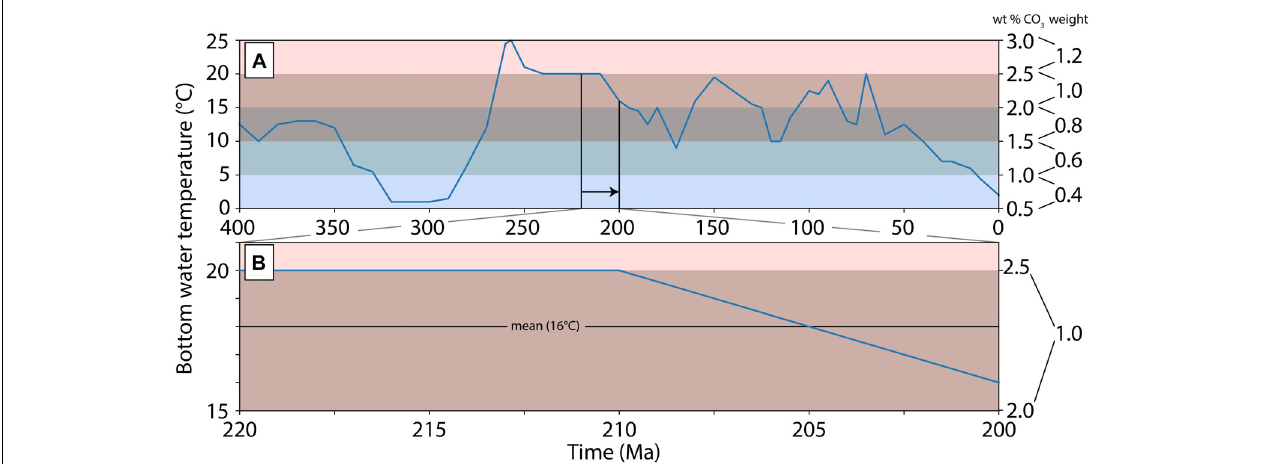
FIGURE 3 | (A) Bottom water temperature curve from 400 to 0 Ma with a resolution of 10 Ma after Müller and Dutkiewicz (2018). Wt% carbonate and the applied weighting factor prescribed in 5 ◦ C bands. The bands are represented by the horizontal colored bars. (B) Calculated mean water temperature using a moving 20 Ma window to scale carbonate wt%. At each time step we perform (B) to determine the average bottom water temperature of a parcel of fresh oceanic